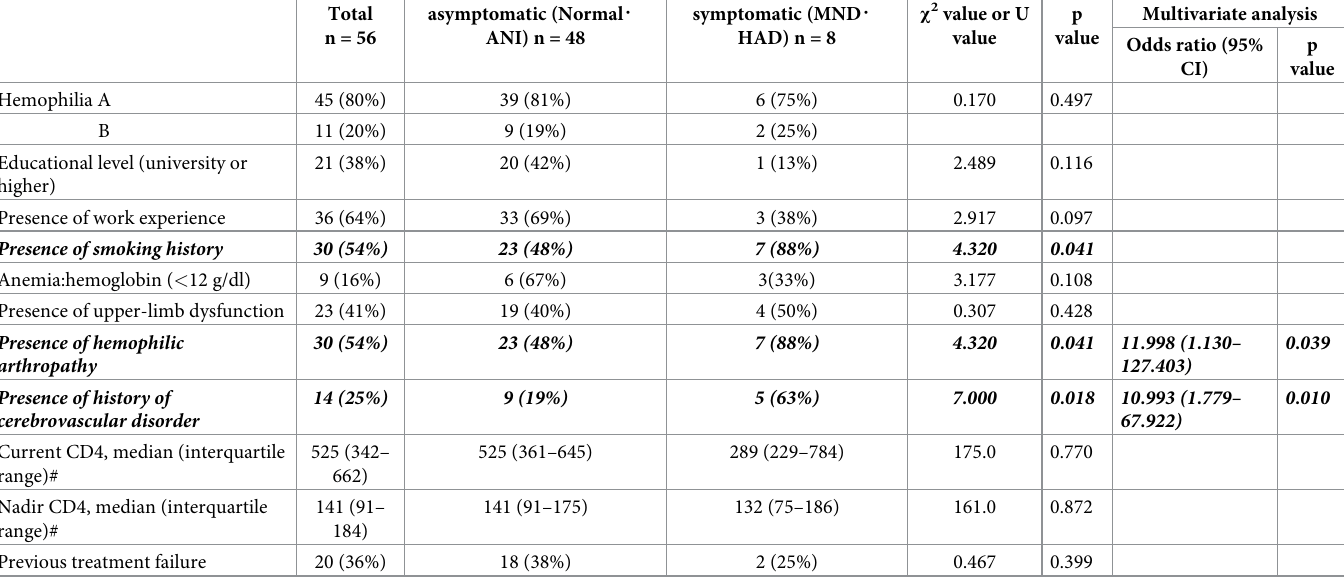
Table 4. Associated factors in the symptomatic